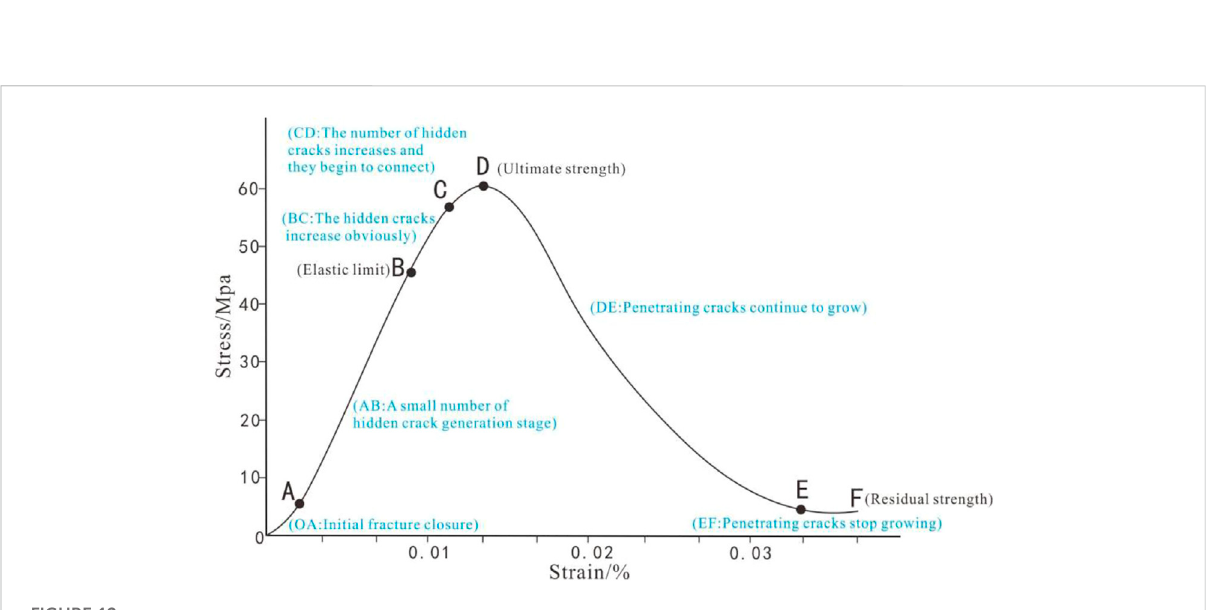
FIGURE 12 Relationship between stress and strain of shale